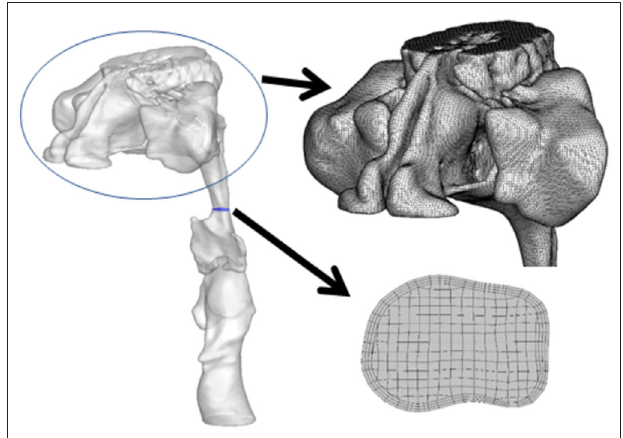
FIGURE 1 | Geometry of upper airway and corresponding computational mesh arrangement.